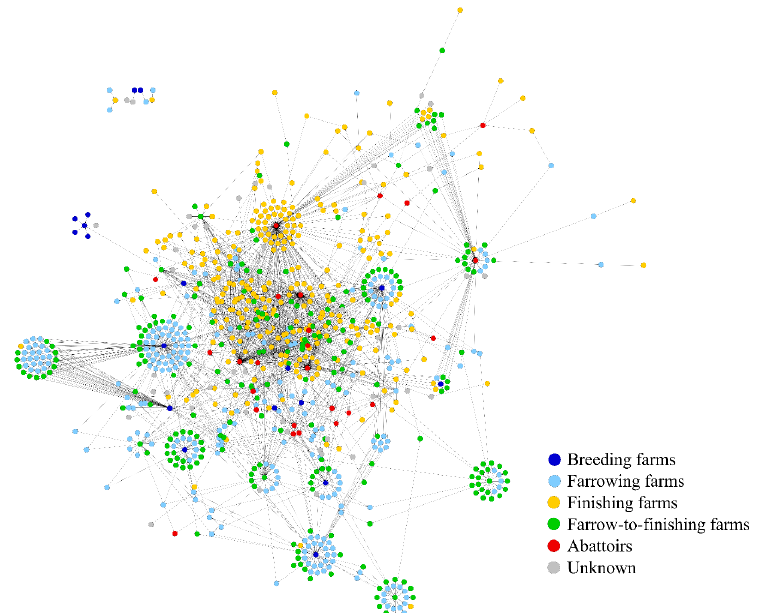
Figure 2. Monopartite animal movements network (AM) of a pork supply chain in Northern Germany covering the observation period from 2013 to 2014. covering the observation period from 2013 to